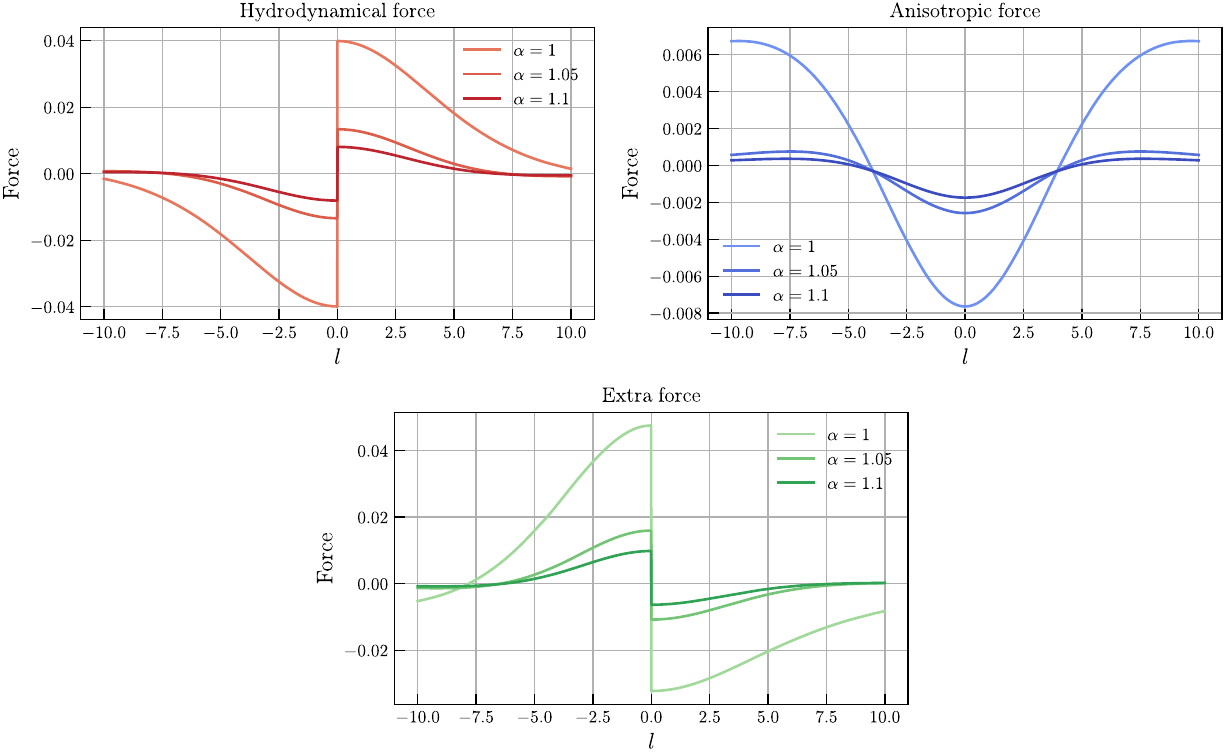
Fig. 6 Forces that are present in the modified TOV equation for the gamma f ( R ) gravity. As usual, we assume that b 0 = 5 and (cid:17) = 1, m = 2, α = 0 . 5 and β = 0 . 1. Moreover, to plot the figure we fixed the values of free MOG parameter R ∗ to